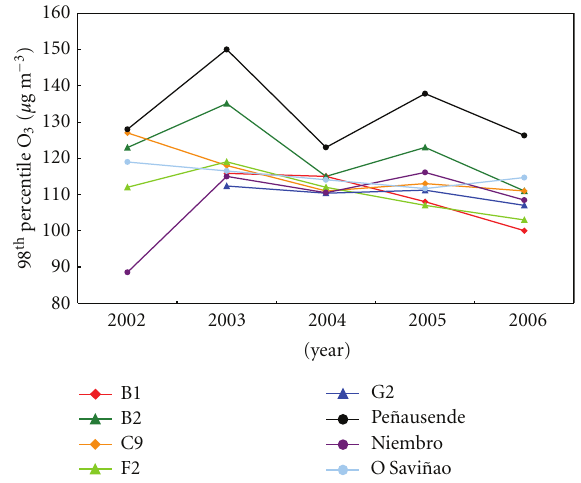
Figure 8: Internannual variability of tropospheric ozone concen- tration represented by the 98th percentile throughout the 5-year- study period (2002–2006) for each